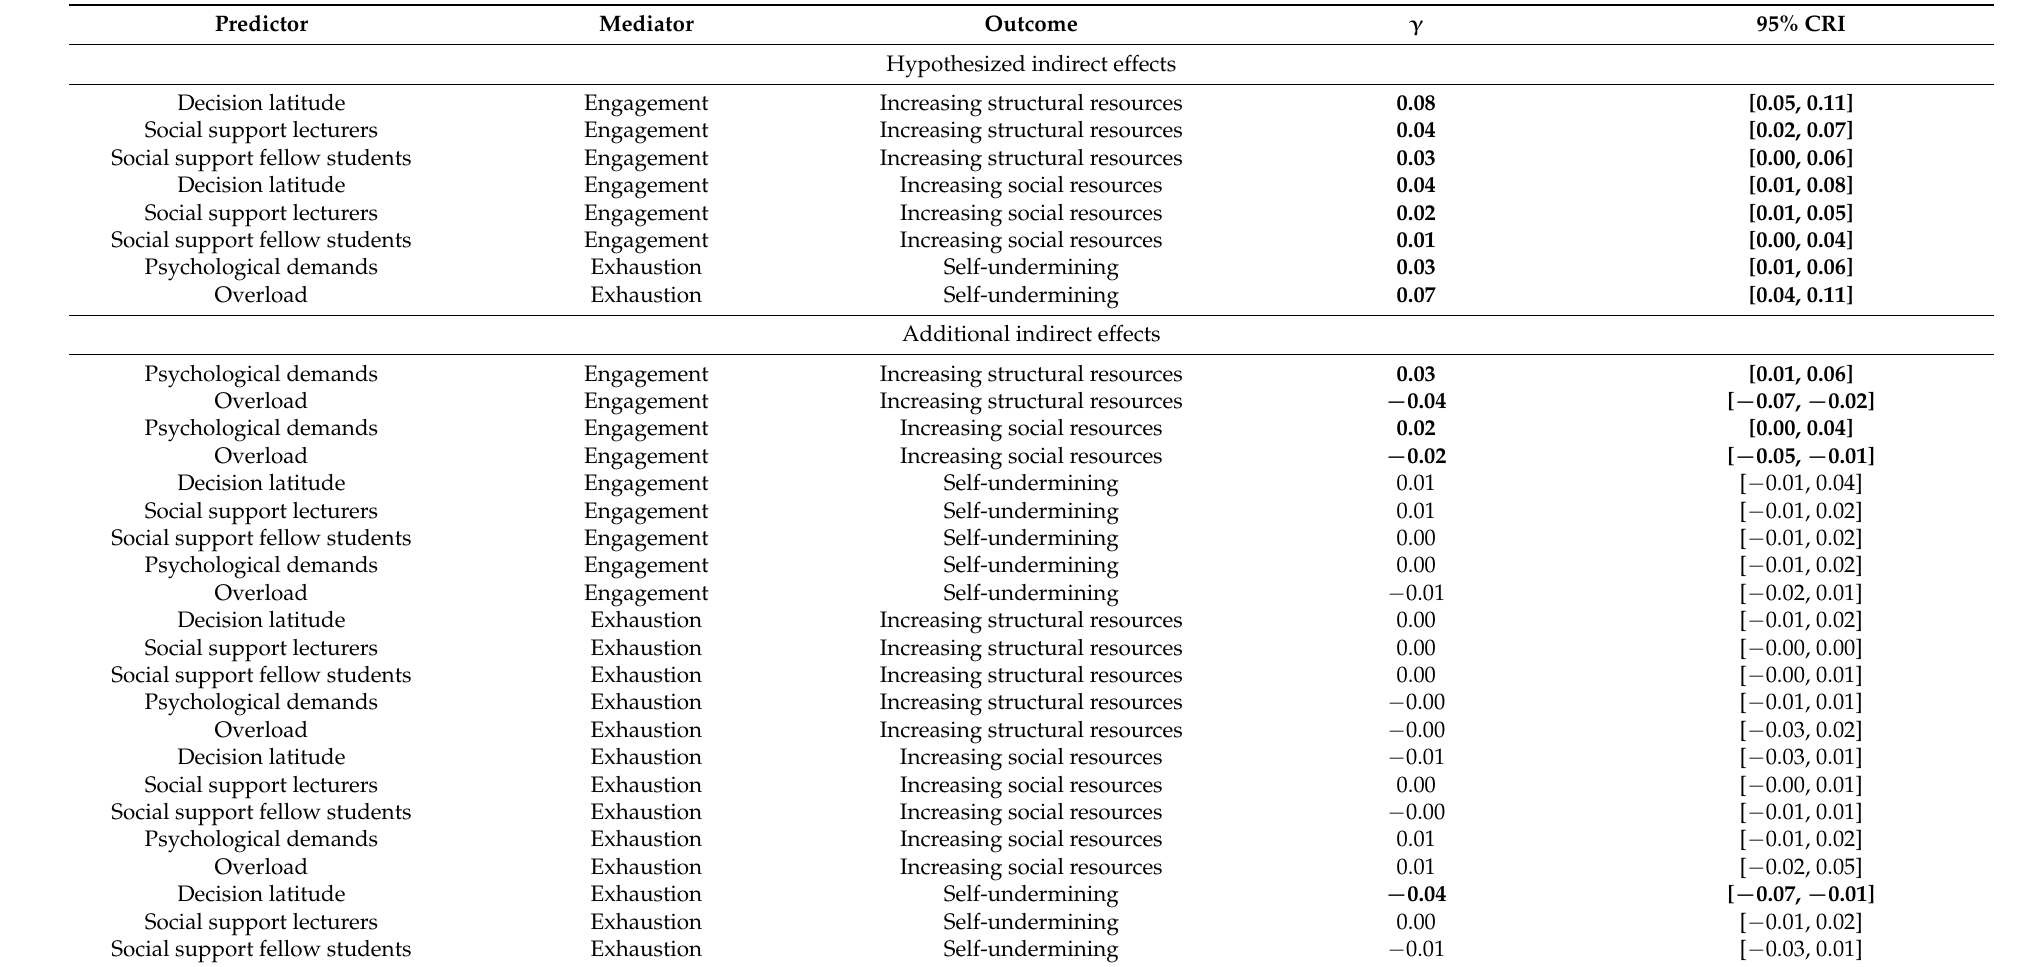
Table 4. Within-person path coefficients and credibility intervals for the indirect